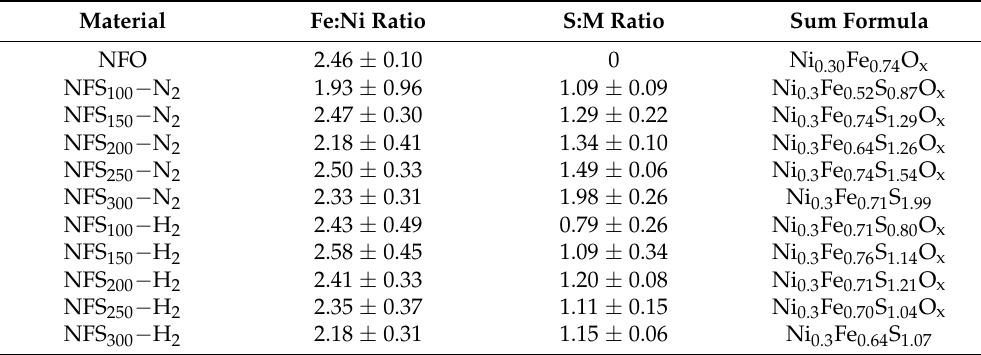
Table 1. Energy-dispersive X-ray emission (EDX) analysis of the investigated electrocatalysts displaying the obtained Fe:Ni and the S:M ratio.